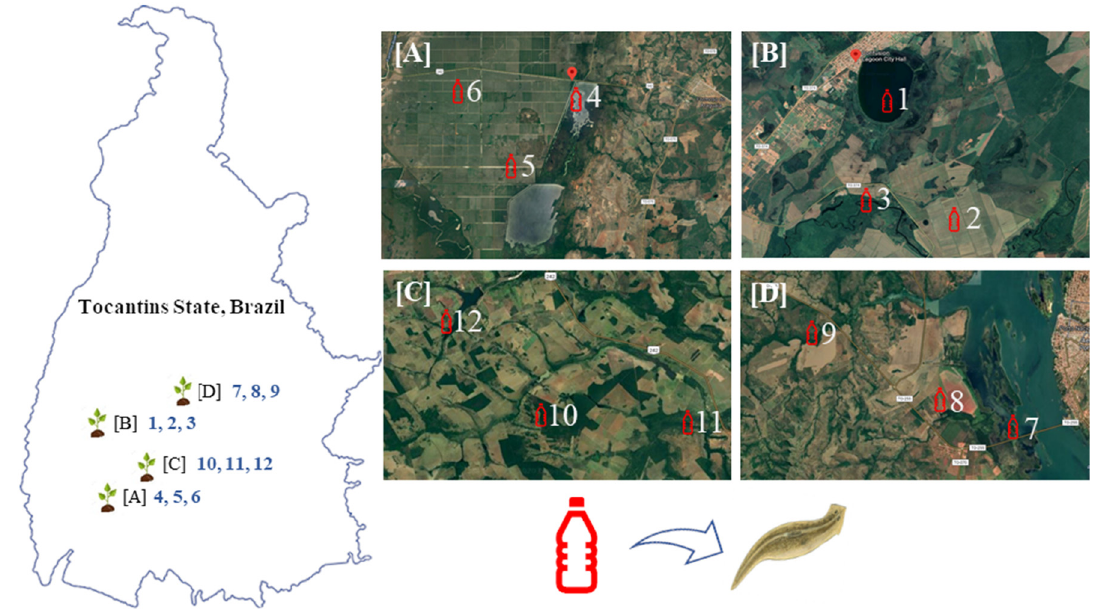
Figure 1. Map of Tocantins-Araguaia hydrographic region (TAHR), Brazil. ( A ) Formoso do Araguaia, 4 (Taboca), 5 (small irrigation channel), 6 (large volumes of water in the channel); ( B ) Lagoa da Confusão, 1 (lake), 2 (water channel), 3 (Urubu river); ( C ) Gurupi, 10 (Dam Brejo Pantanal), 11 (Santo Antônio river), 12 (Reference, dam with crystal clean water); ( D ) Porto Nacional, 7 (Tocantins river), 8 (large volumes of water in the channel), 9 (small irrigation channel); adapted from Google Maps and Google Earth (2020). = Water collection sites. Water collected in each site was used to expose adult planarians ( G. tigrina ) in the laboratory.